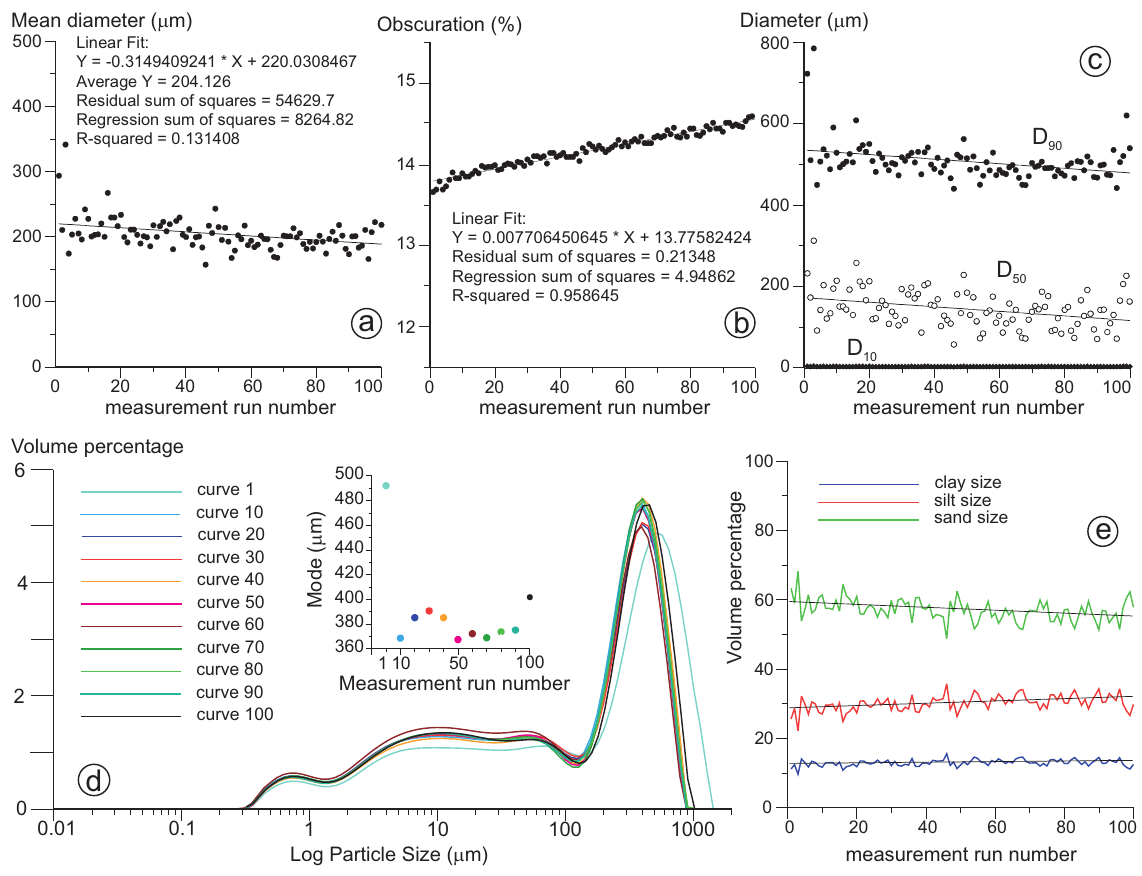
Fig. 9. Results of the measurement precision test MP2000 5 performed on sub-sample aliquot CABRE3d by the Hydro 2000 MU dispersion unit. (a) Mean diameter value evolution with increasing the number of measurement runs. Data statistics are provided. (b) Laser obscuration value progression during the same test. Data statistics are provided. (c) Progression of D 10 , D 50 , and D 90 percentiles during the same test. (d) Granulometric curves representative of the particle size evolution. The corresponding modal values (same colour code) are illustrated in the inset graph. (e) Distribution of the clay, silt and sand size fractions during the test.